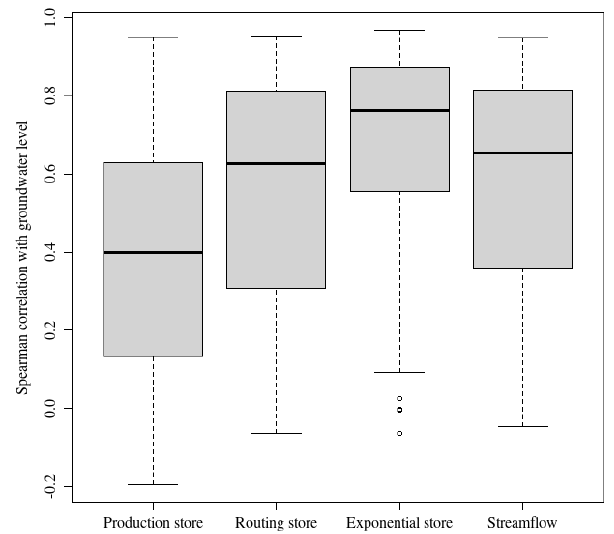
Figure 5. Distributions of the correlations between piezometry and several states of the